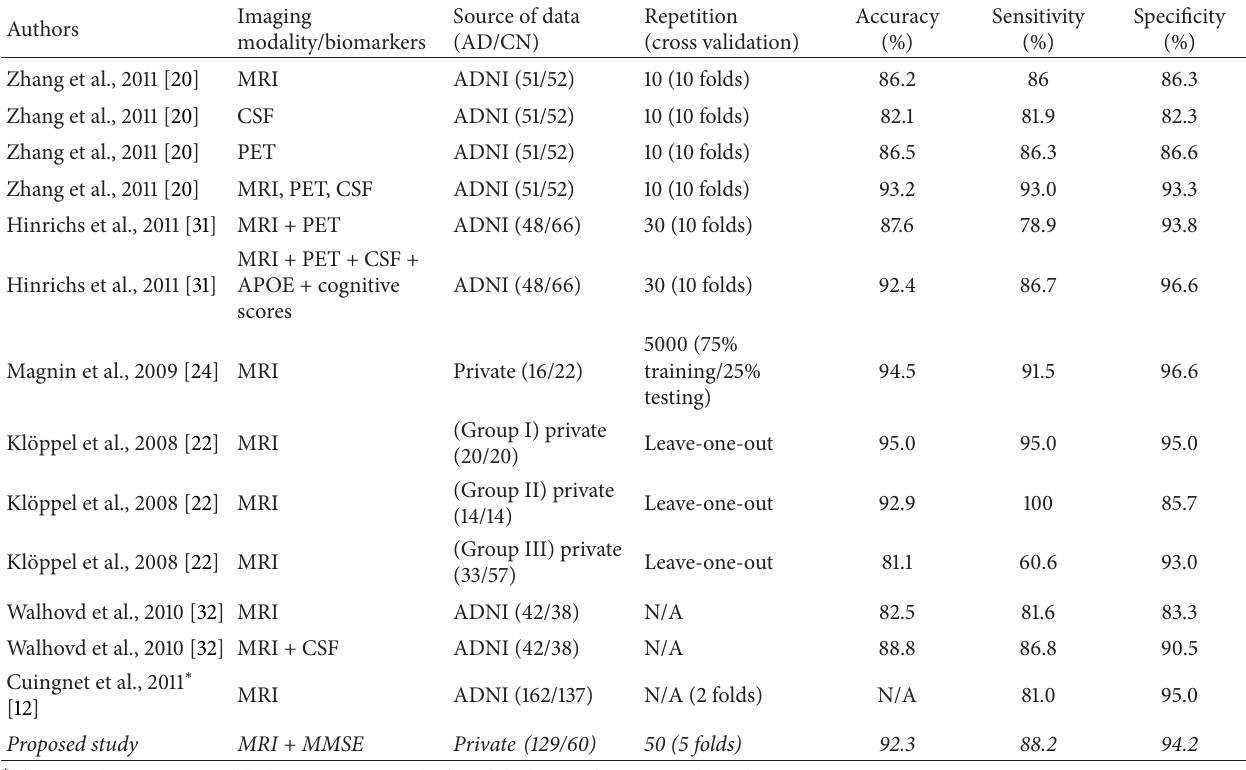
Table 5: Performance comparison of different